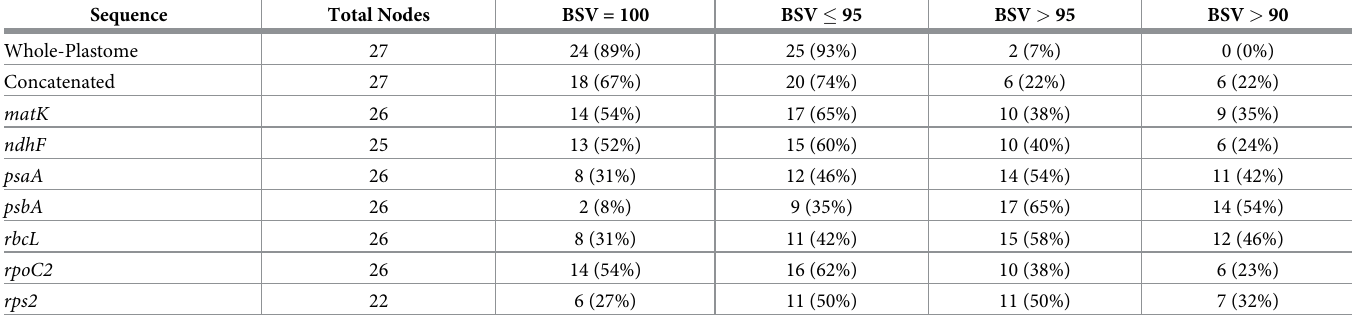
Table 5. Comparison of nodal support in our plastid phylogenetic trees. The node count and percentages for each phylogeny based on whole-plastome, individual gene sequences ( matK , ndhF , psaA , psbA , rbcL , rpoC2 , and rps2 ), and concatenated sequences with the specified level of nodal support.